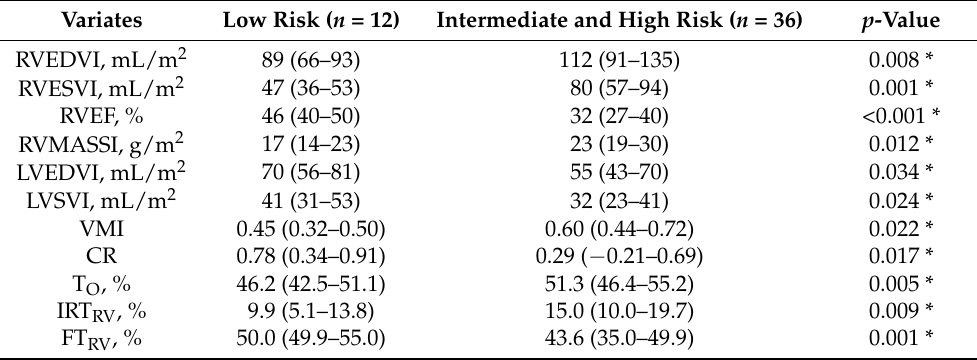
Table 6. Comparison of the CMR-derived indices and RHC characteristics of the PH patients based on risk stratification.